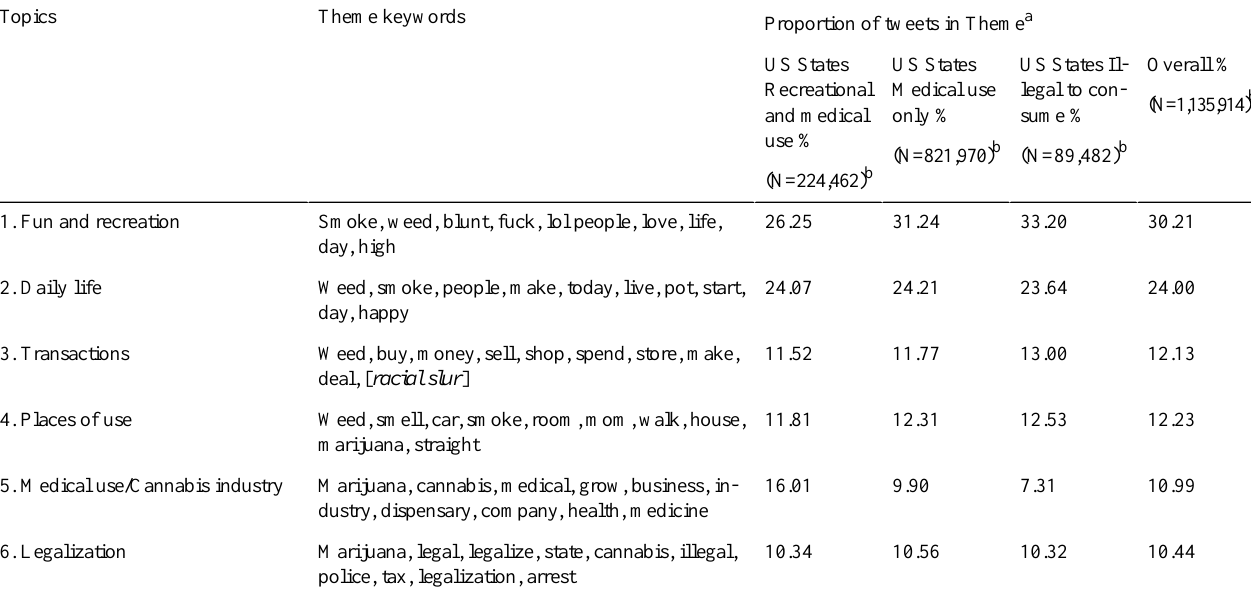
Table 2. Topics in cannabis-related tweets by state legal category groupings, United States, January 2017-2019.